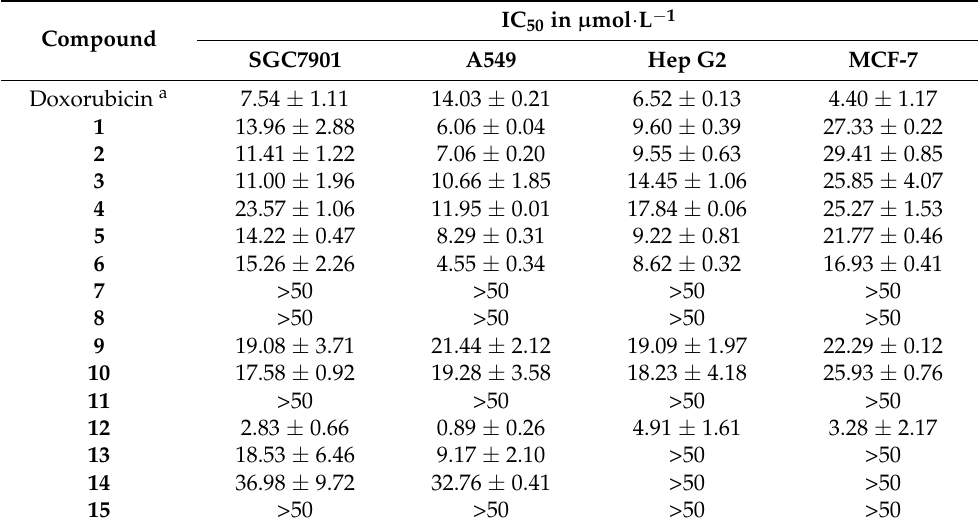
Table 3. Anti-proliferative activity of isolated compounds b